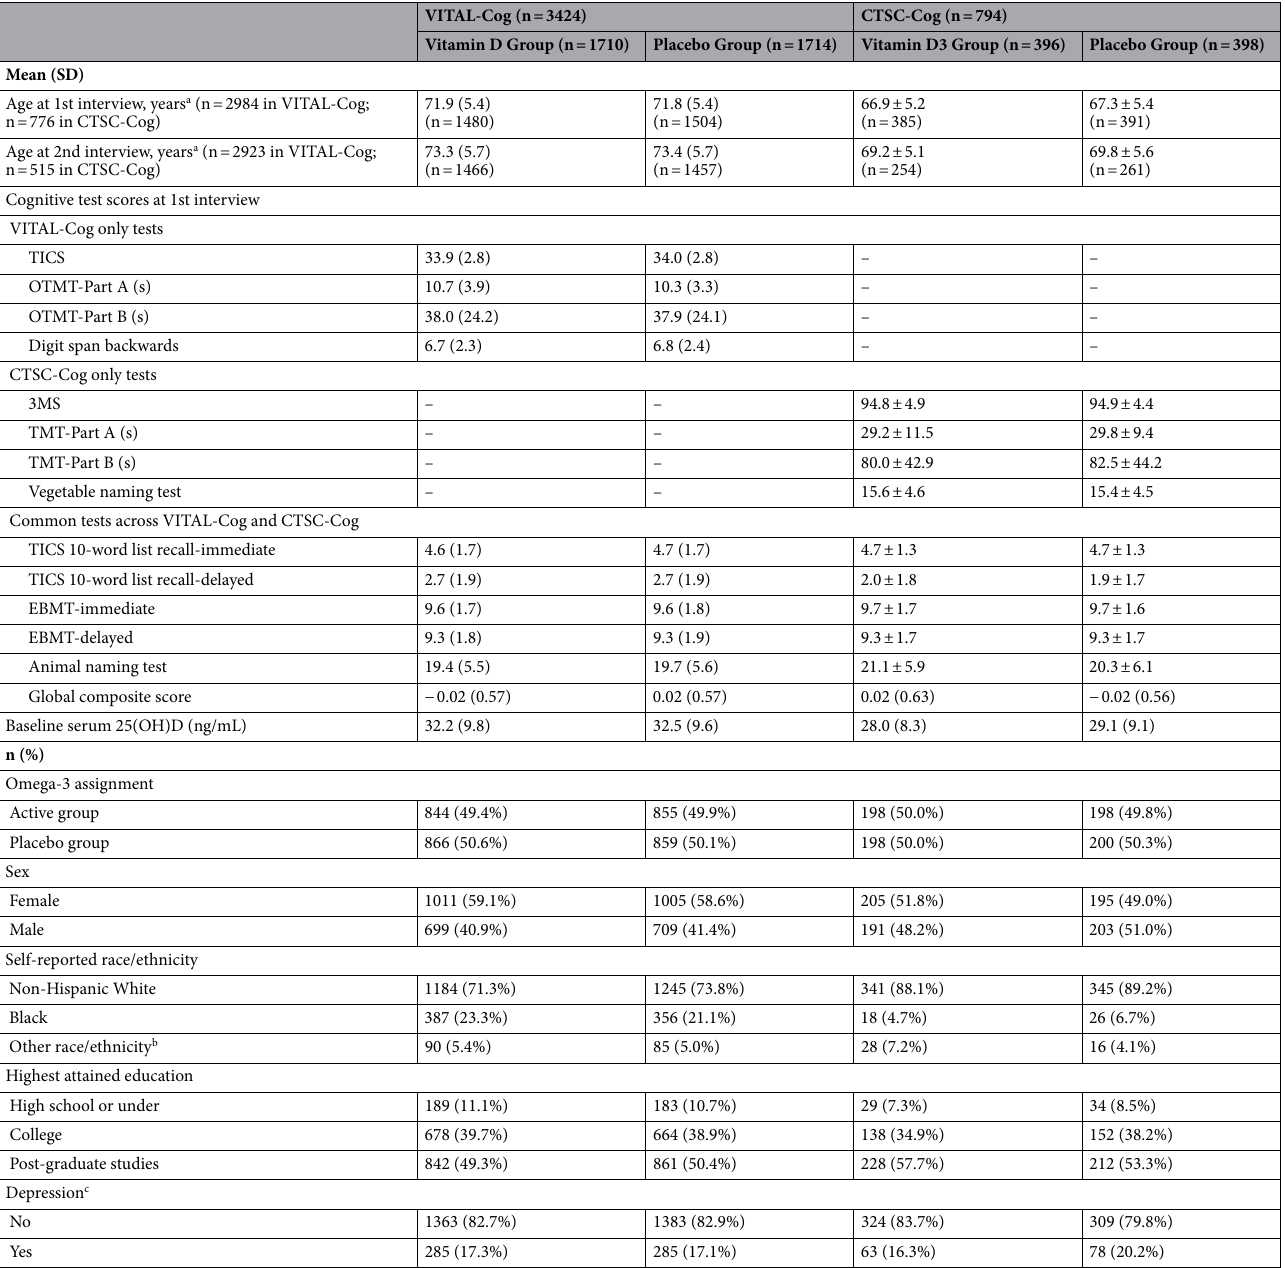
Table 1. Baseline characteristics of participants aged 60+ years in the VITAL cognitive substudy by vitamin D supplement assignment for VITAL-Cog (n = 3424) and CTSC-Cog (n = 794). 3MS Modified Mini- Mental Status exam (range = 0–100) 33 ; CTSC Clinical and Translational Science Collaborative Center for